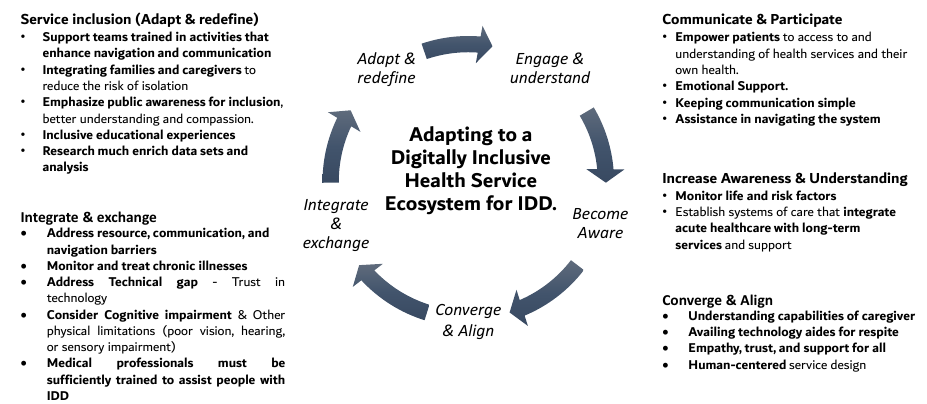
Fig. 2. Fundamentals of a Digitally Inclusive Health Service Ecosystem for people with